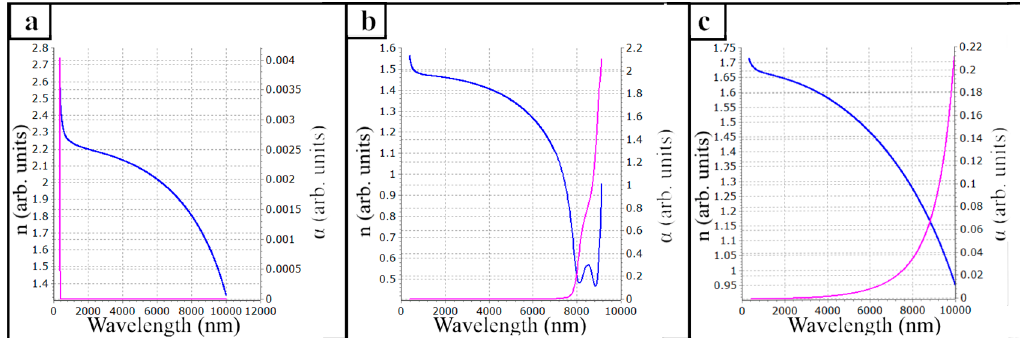
Figure 3. Calculated Optilayer dependences of the refractive index and the absorption coefficient on the wavelength: ( a ) Nb 2 O 5 monolayer, ( b ) SiO 2 monolayer, ( c ) Al 2 O 3 monolayer.